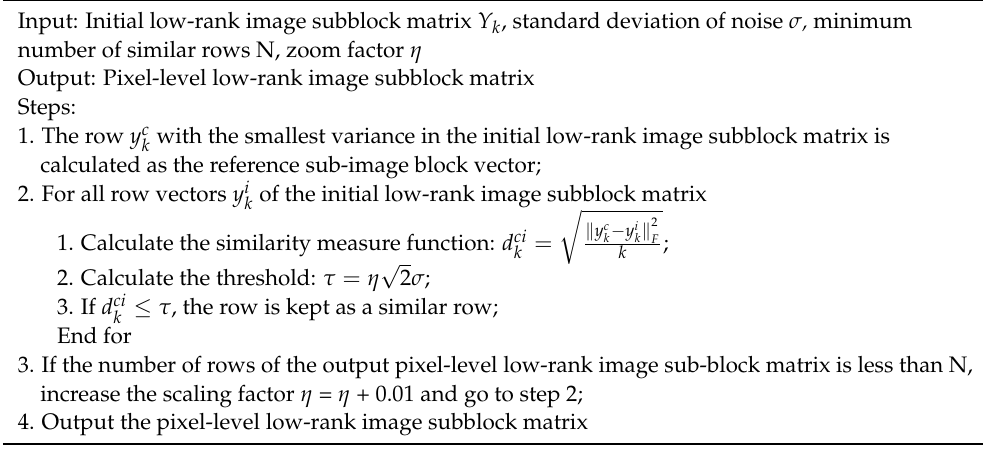
Algorithm 2: Construction method of pixel-level low-rank image subblock